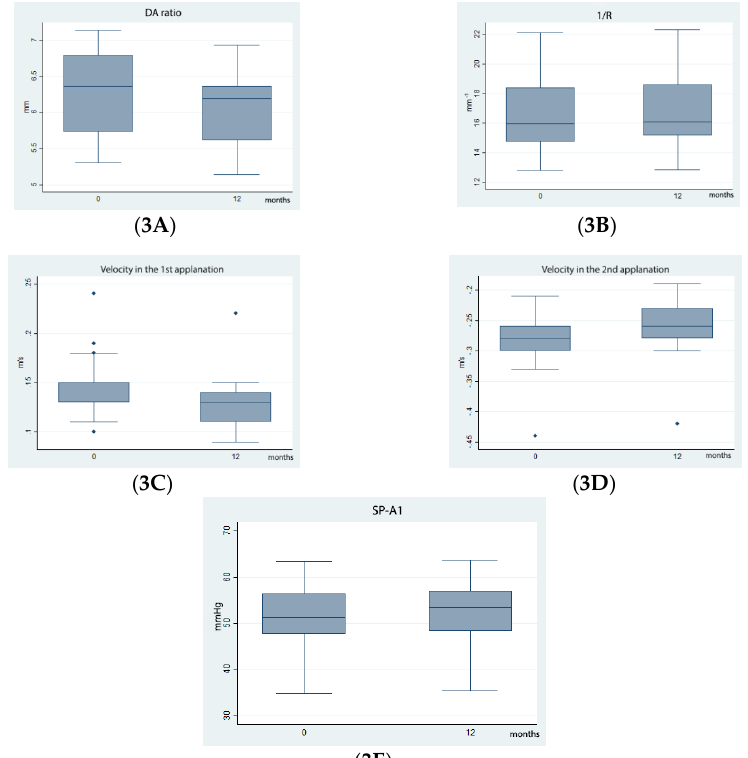
Figure 3. Biomechanical changes after CXL.